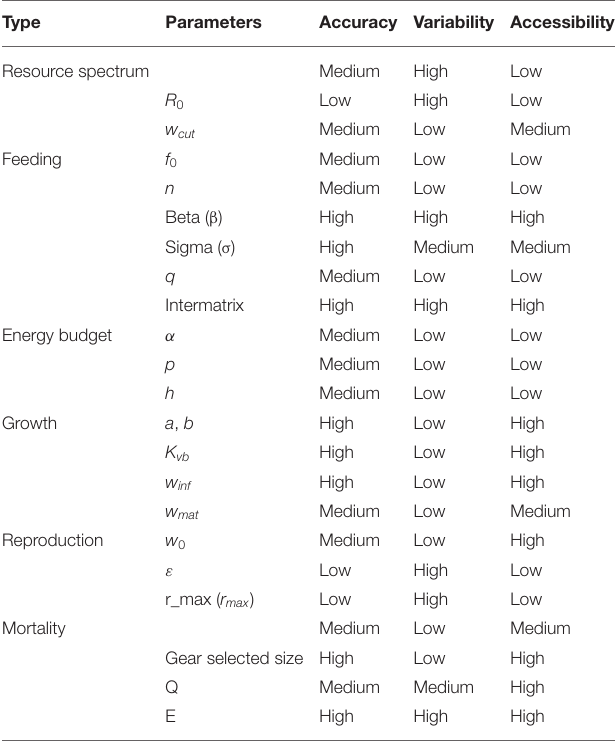
TABLE 2 | Assessment of parameters uncertainty with different data